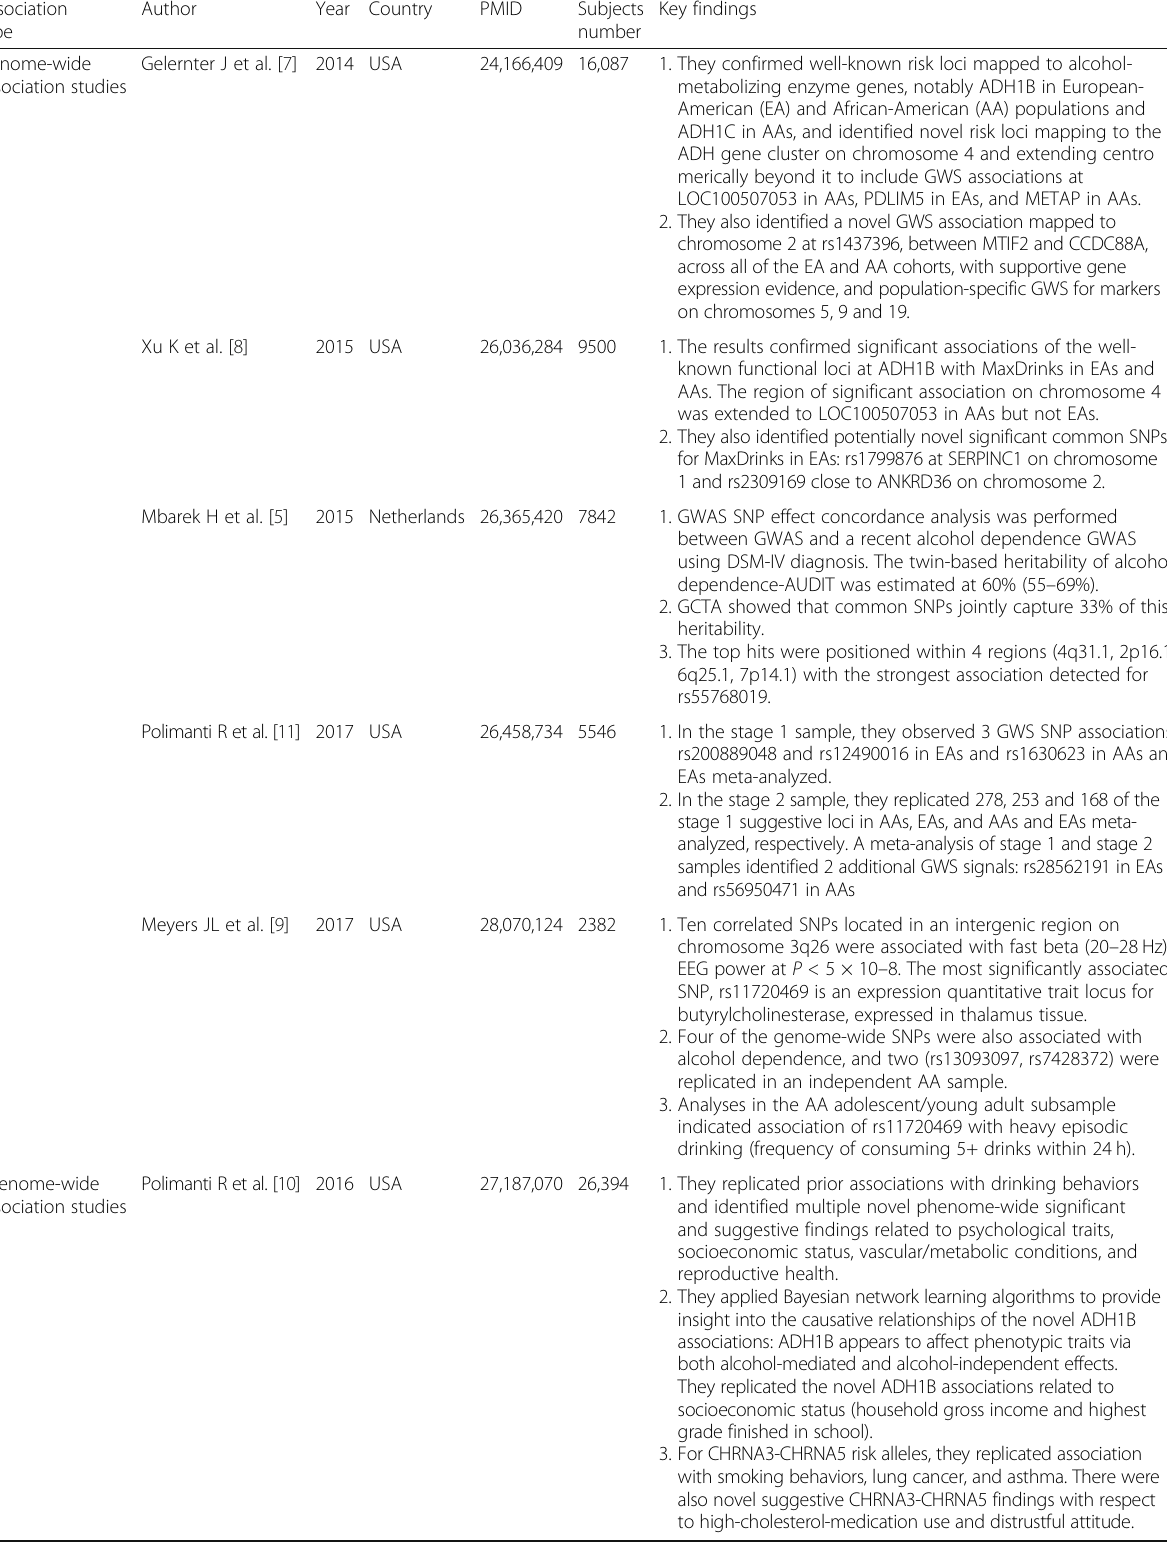
Table 1 Previous studies about genome- or phenome-wide association studies of alcohol dependence Association